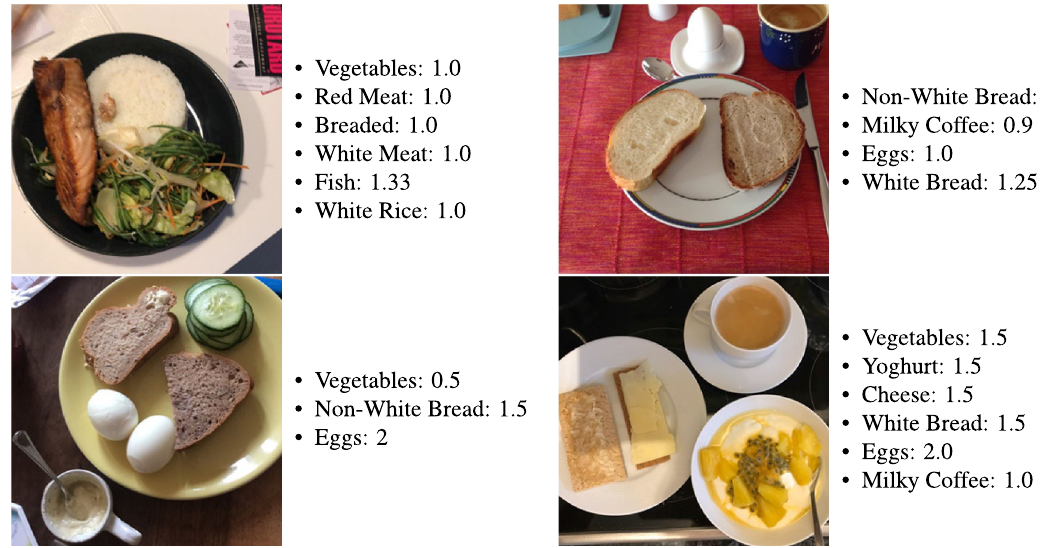
Figure 1. Example images of the training set (upper row) and the testing set (lower row) of the database, along with their